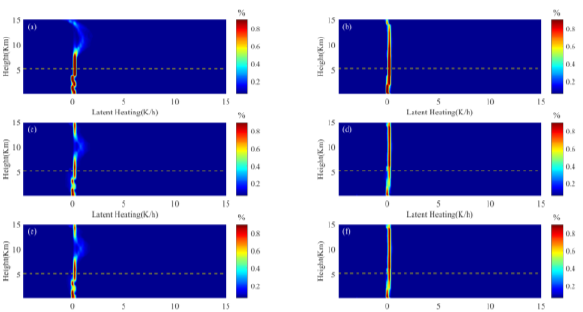
Figure 6. The frequency pattern in two-dimensional space of Ice water path and Liquid water path for stratiform and convective precipitation at each stage. The upper row (a)-(c) (lower row (d)-(e)) represent the style of stratiform cloud precipitation (convective cloud precipitation), while columns 1 to 3 represent developing, mature, and dissipating